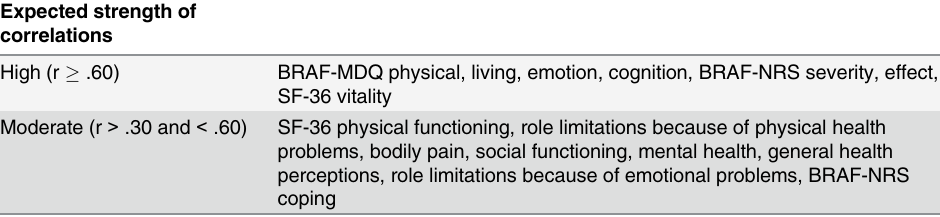
Table 1. Hypothesised strength of correlations with CAT severity, impact and variability. Expected strength of